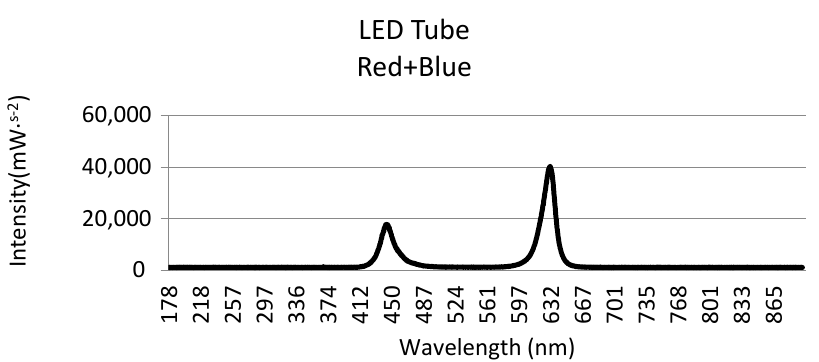
Figure 5. Spectral characteristic of red + blue light.